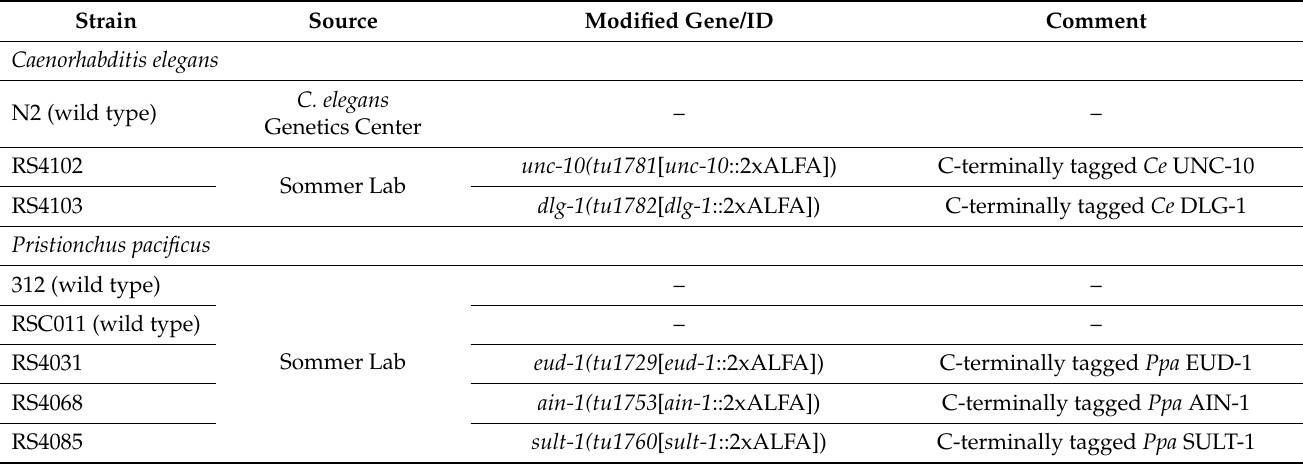
Table 1. Organisms/strains used in this